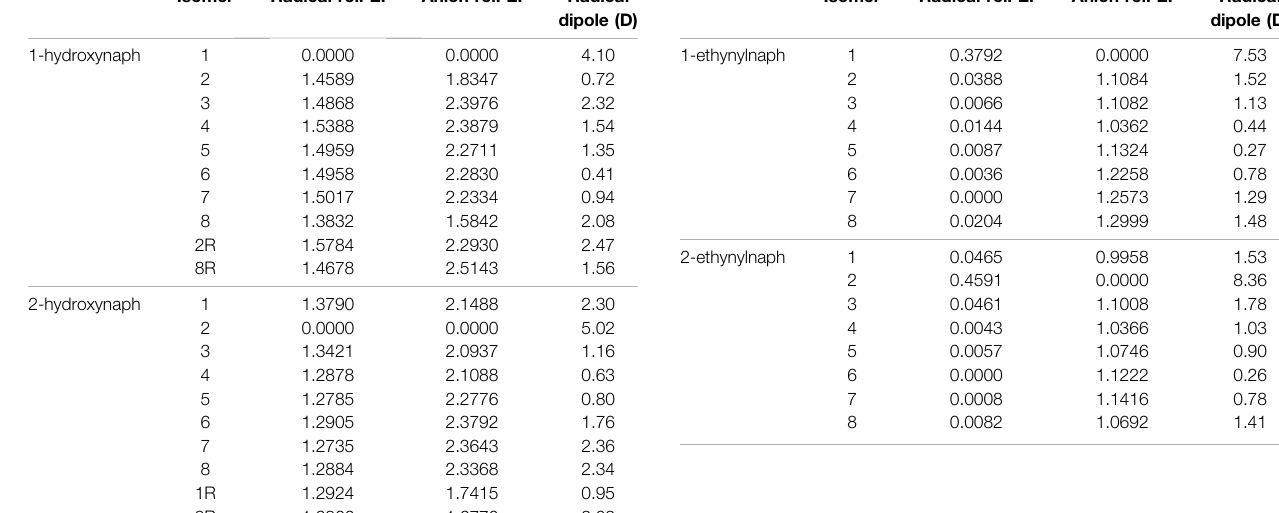
TABLE 4 | The relative energies and neutral radical dipole moments of ethynylnaphthalene derivatives. Isomer Radical rel. dipole (D)